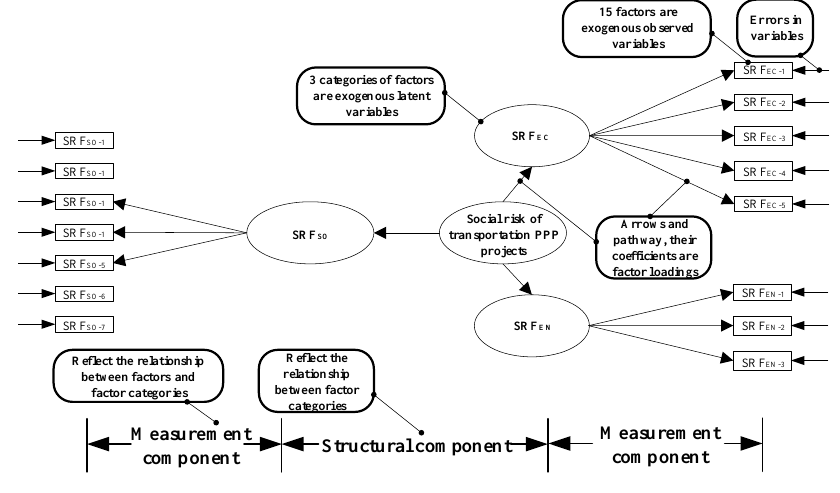
Figure 4. The hypothesized model for CFA.